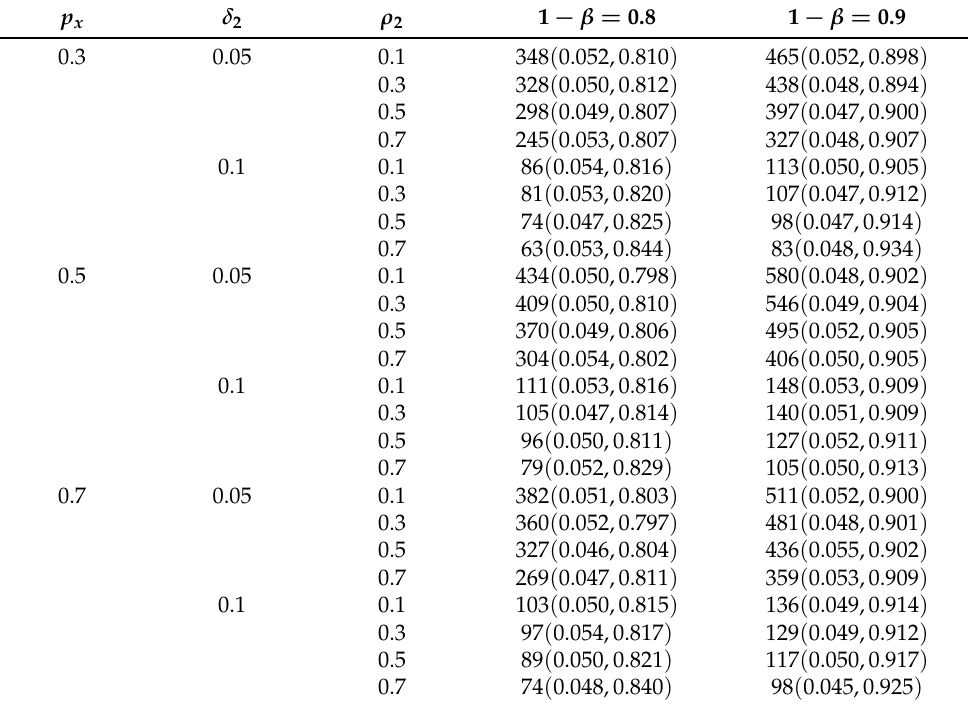
Table 2. Sample size (empirical type I error rate, empirical power), n ( ˆ α ,1 − ˆ β ) , under various design settings of ( p x , δ 2 , ρ 2 ,1 − β ) for the second type of study